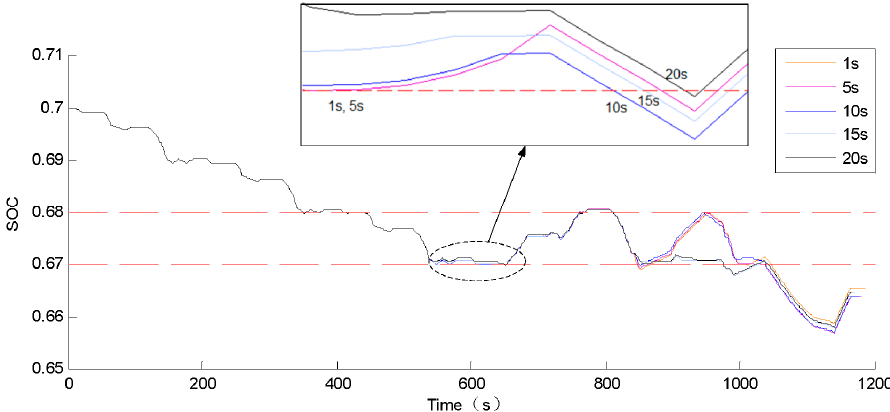
Figure 14. Battery SOC curve under different prediction horizons. Table 8. SOC bottoming time under different prediction horizons.